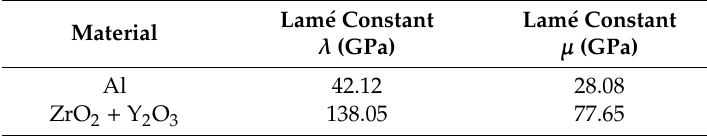
Table 6. Material properties of metallic matrix and ceramic phase [34,35].